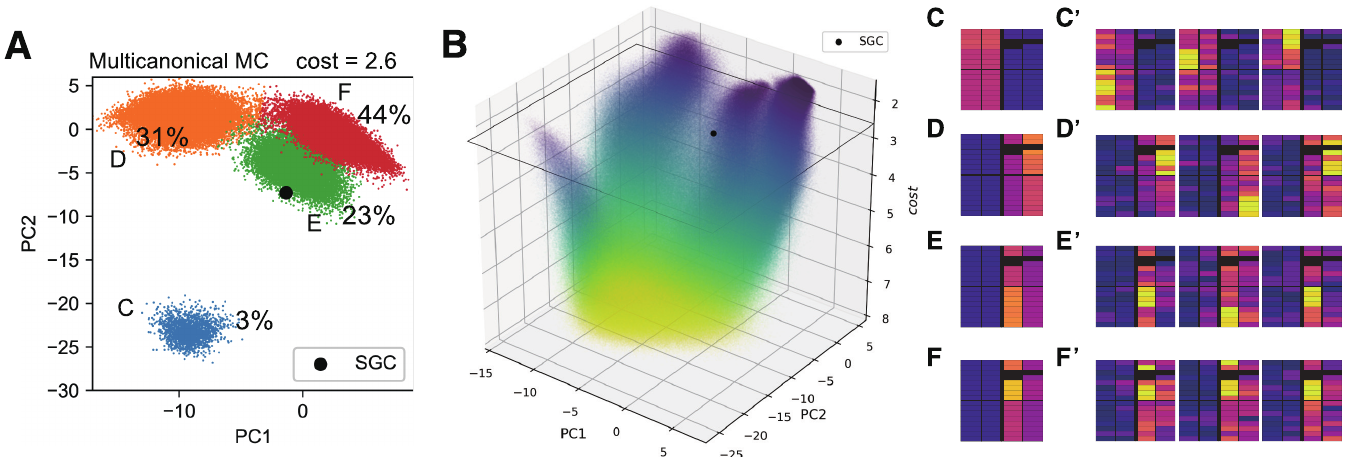
Fig 2. Fitness landscape under a random genetic code ensemble. (A) Genetic codes with comparable cost values to the SGC, where 2.6 − Δ < cost < 2.6 + Δ ( Δ = 0.1) in the PC1-PC2 space (the contribution ratios: PC1, 27%, PC2, 14%). Principal component analysis and k-means clustering were performed using the sampled data with a cost value of cost < 2.6 + Δ . (B) Fitness landscape visualized by piling up the scatterplot on the PC1-PC2 plane, with costs decreasing on the vertical axis, where low cost corresponds to high fitness. (C-F) Average structure of the genetic code in each cluster. (C’-F’) examples of samples belonging to the clusters (C-F) in (A).